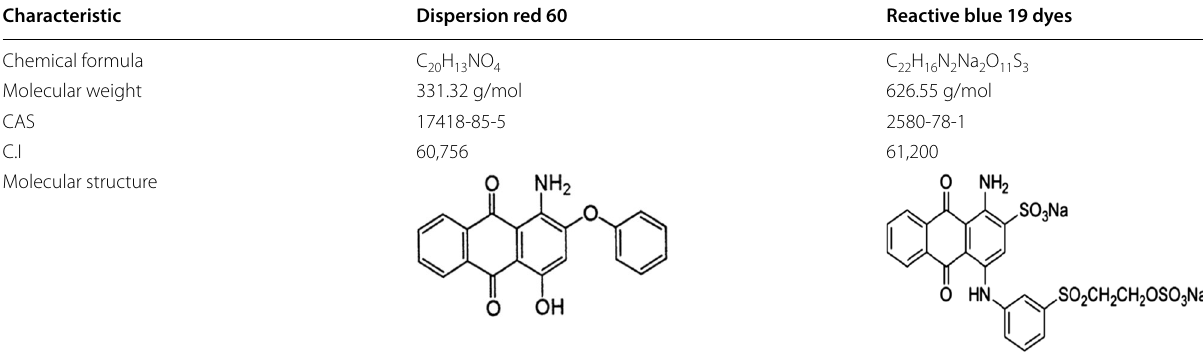
Table 1 Basic properties of the investigated dyes (Siddique et al. 2011; El-sayed et al. 2012)